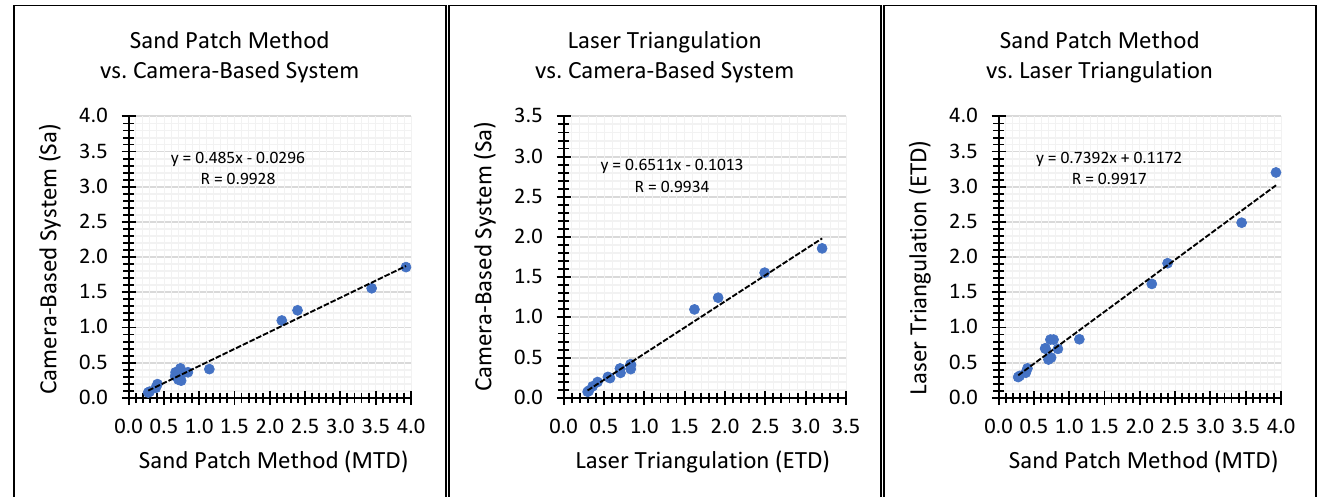
Figure 14. Correlations between the measurement series of the three methods deployed on the 16 concrete specimens—left sand patch method and camera-based system, center laser triangulation and camera-based system and right sand patch method and laser triangulation.